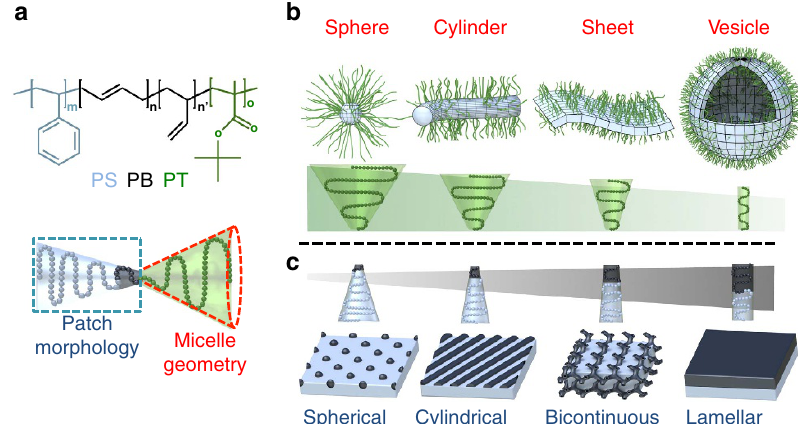
Figure 1 | Parameters controlling micelle geometry and patch morphology. ( a ) Chemical structure of the polystyrene- block -polybutadiene- block -poly ( tert -butyl methacrylate) triblock terpolymer (SBT). ( b ) Suggested structural control: the length of the soluble PTcorona (green chain) controls the micelle geometry to spheres, cylinders, bilayer sheets and vesicles; ( c ) the block lengths of the insoluble and immiscible blocks, PS (grey) and PB (black), determine the patch morphology to spherical, cylindrical, bicontinuous and lamellar.